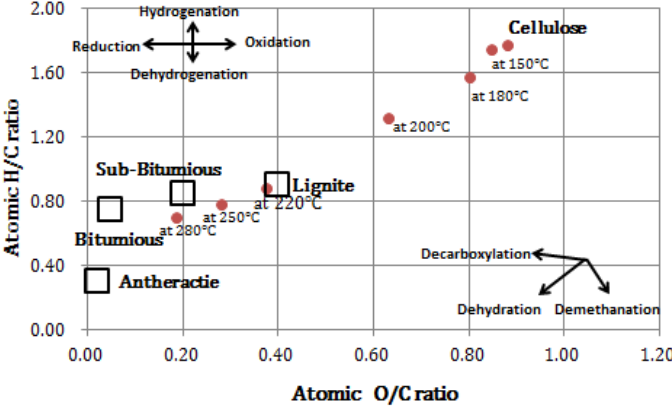
Figure 2. van Krevelen diagram of cellulose and its hydrothermally ‐ obtained biochar based on the effect of the reaction temperature.